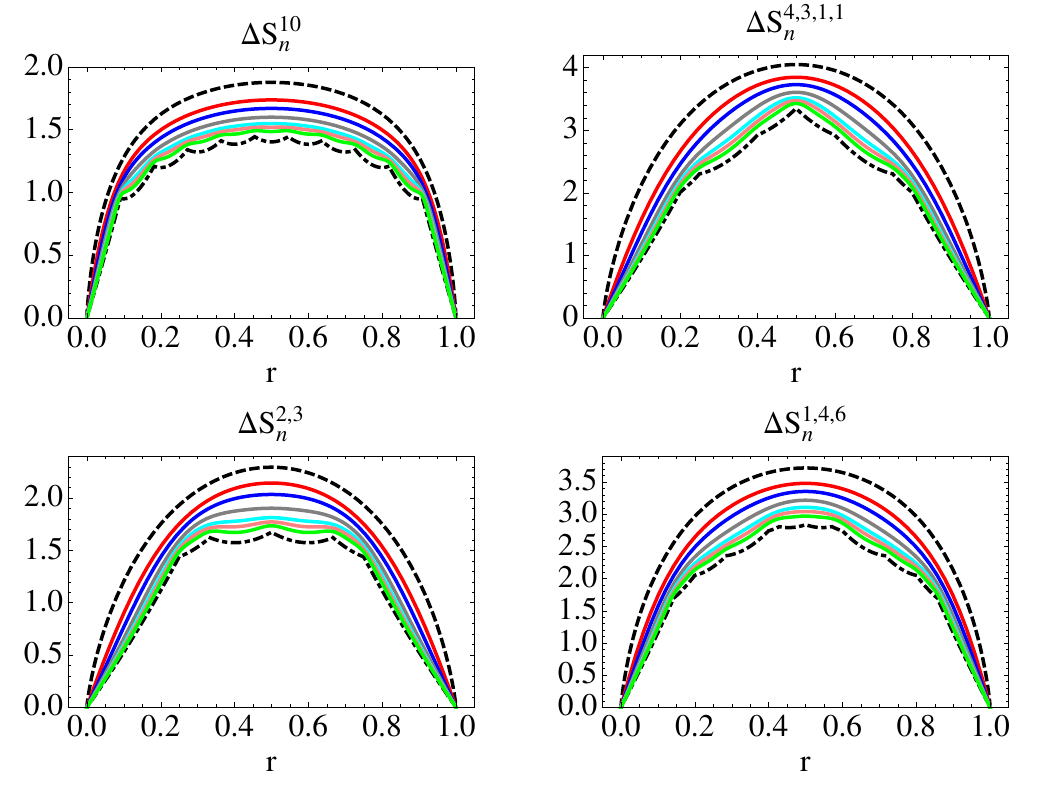
Figure 2 . The functions (2.4), (2.5) and (2.7) for a state of 10 equal momenta and for three \mixed" states with some equal and some distinct momenta. We plot the R(cid:19)enyi entropies for n = 2 ; 3 ; 5 ; 8 ; 11 ; 17 and the von Neumann and single-copy entropies. In each (cid:12)gure, the dashed (outer-most) curve is the von Neumann entropy and the dot dashed (inner-most) curve is the single-copy